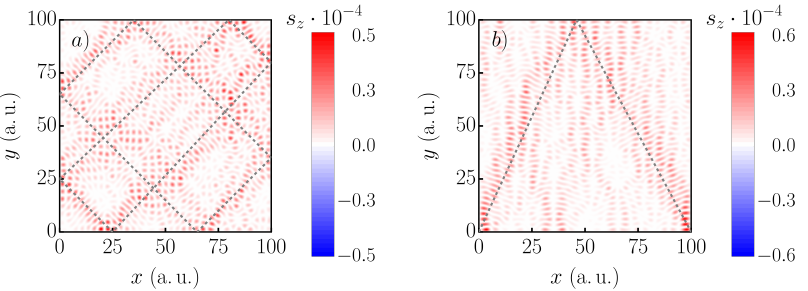
Figure 4. Spatially resolved s z component of the states 2887 and 2949 of a square with a size of 100 × 100a.u., α = 25meVÅ, B = 100mT. Ten impurities of strength M = 0.18a.u. and FWHM = 2.6a.u. are randomly positioned inside the square. The classical trajectories are indi- cated by dashed lines. The trajectory in Panel ( a ) is open, while in ( b ), two closed paths are shown. Both states are mostly in the spin-up state, which corresponds to (cid:104) s z (cid:105) (cid:39) 1. Note the different scale of the color bars. The oscillations of the lower state are ≈ 0.05a.u.